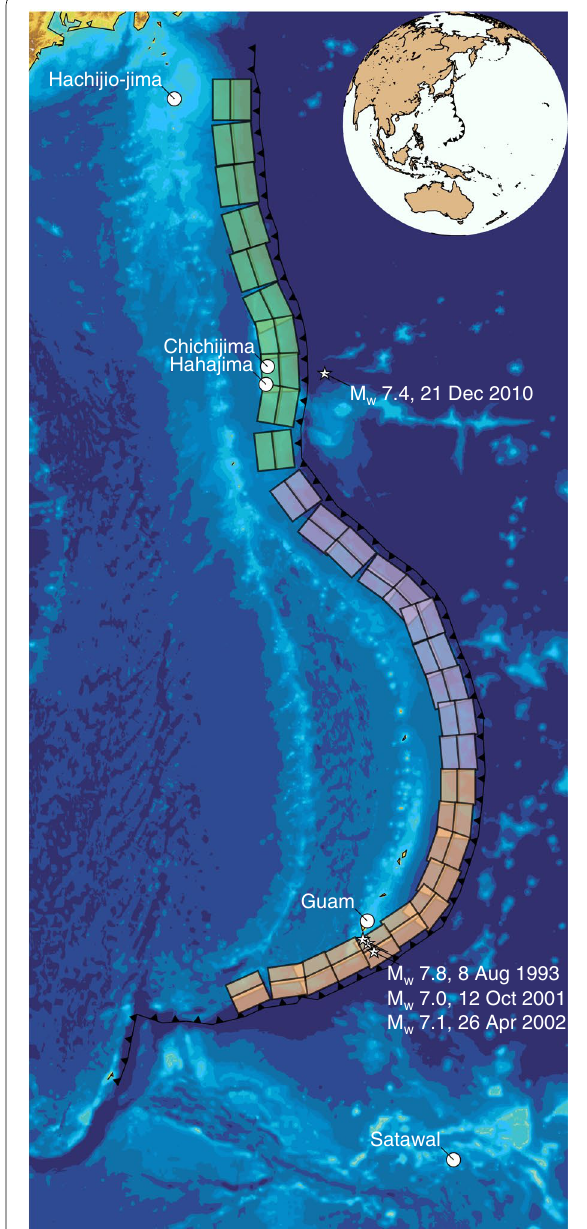
Fig. 1 Location of the Izu–Bonin–Mariana subduction system. Stars represent the four largest, shallow focus, instrumentally located earthquakes in the subduction system. Circles represent locations mentioned in this manuscript. Colored rectangles denote faults from the NOAA SIFT fault model database. The colors represent the fault segments used in this paper: the green segment is the Izu–Bonin segment, the purple segment is the north Mariana, and the orange is the south Mariana